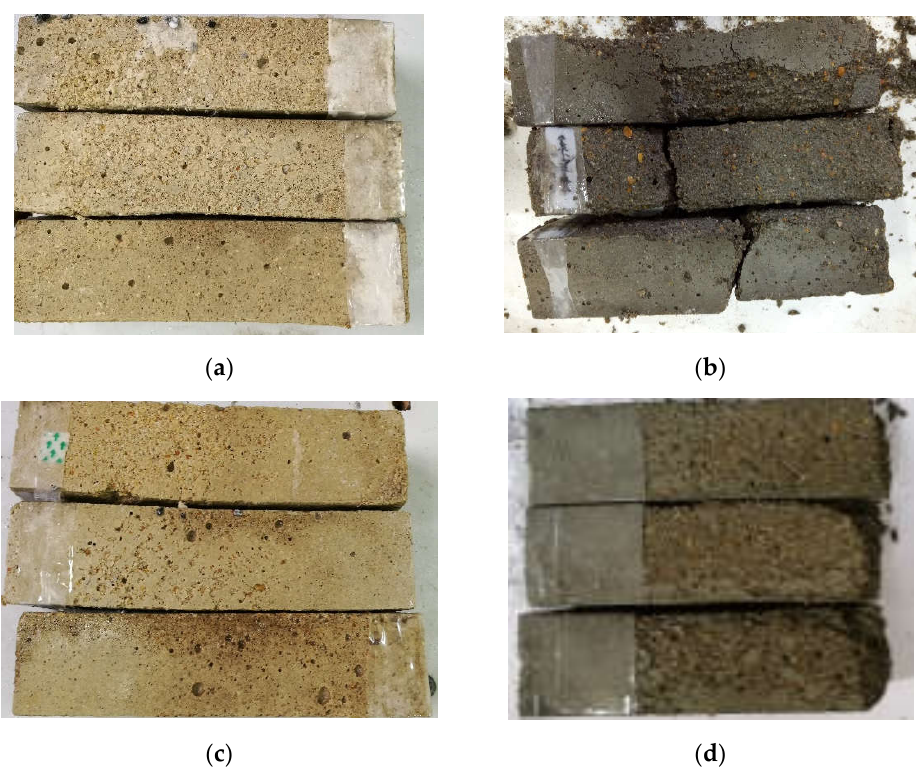
Figure 4. Appearance of MKPC mortar specimens and P.O mortar specimens in a freeze–thaw environment. ( a ) M1, 225 water freeze-thaw cycles; ( b ) M2, 50 water freeze-thaw cycles; ( c ) M1, 225 salt-thaw cycles; ( d ) M2, 25 salt-thaw cycles.